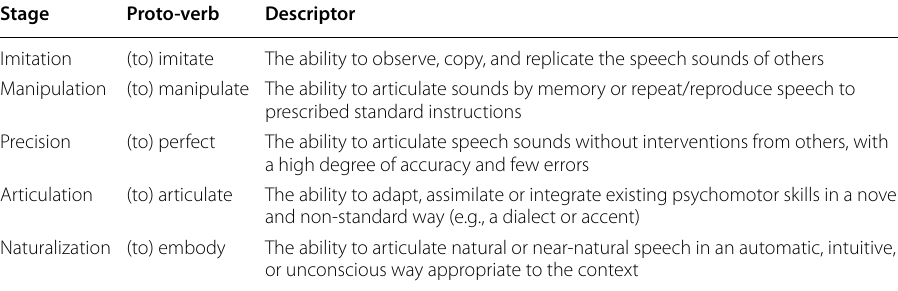
Table 1 The psychomotor domain taxonomy of oral skills (adapted from Atkinson, 2018) Stage Proto-verb Descriptor Imitation (to) imitate The ability to observe, copy, and replicate the speech sounds of others Manipulation (to) manipulate The ability to articulate sounds by memory or repeat/reproduce speech to prescribed standard instructions Precision (to) perfect The ability to articulate speech sounds without interventions from others, with a high degree of accuracy and few errors Articulation Naturalization (to)